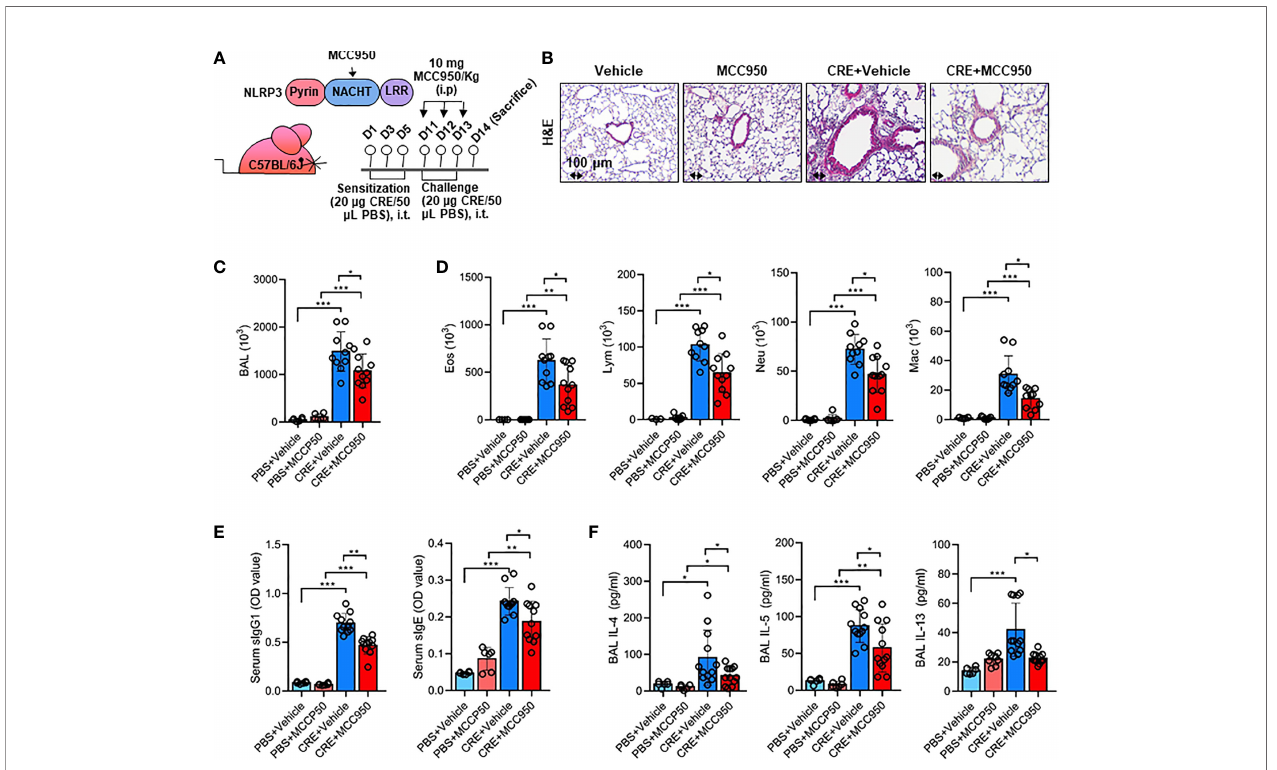
FIGURE 7 | Inhibition of NLRP3 in fl ammasome alleviates cockroach allergen-induced airway in fl ammation. (A) Experimental scheme for cockroach allergen-induced mouse model of asthma. (B) Histological examination of mouse paraf fi n lung sections stained with hematoxylin and eosin (H&E). (C, D) Bronchoalveolar lavage (BAL) fl uid total (C) and differential (eosinophil, macrophage, neutrophil, and lymphocyte, (D) cell counts as assessed by fl ow cytometry. (E) Serum levels of cockroach allergen-speci fi c IgE and IgG1. (F) Levels of cytokines in BAL fl uids. E-G, n = 6-11. Data represent means ± SEM. * p < 0.05, ** p < 0.01, *** p <